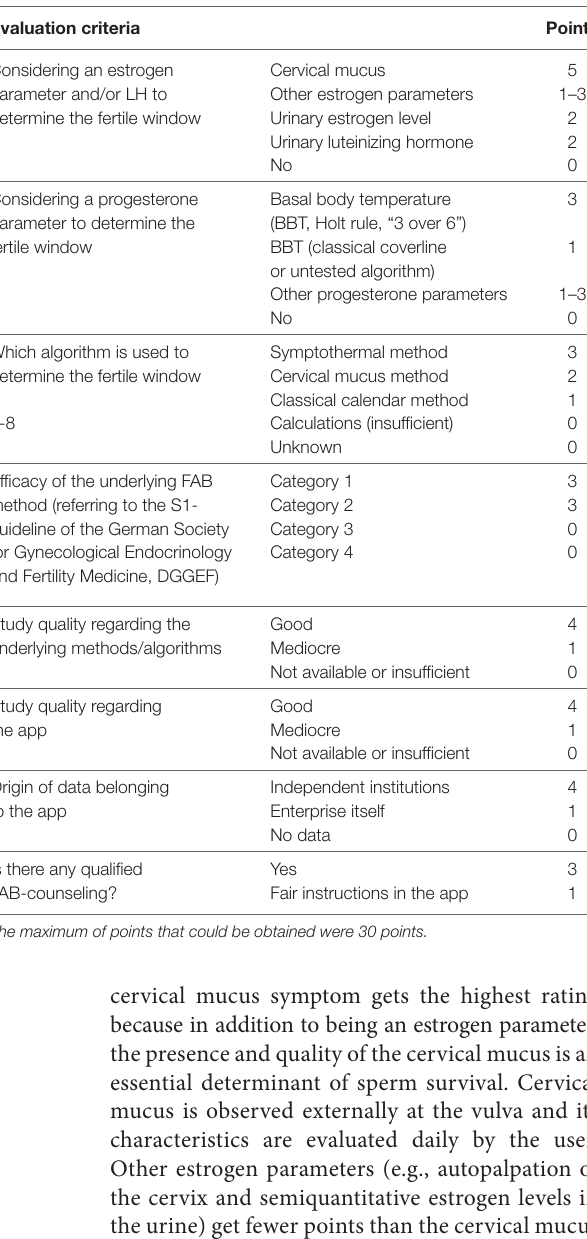
Table 2 | Scoring